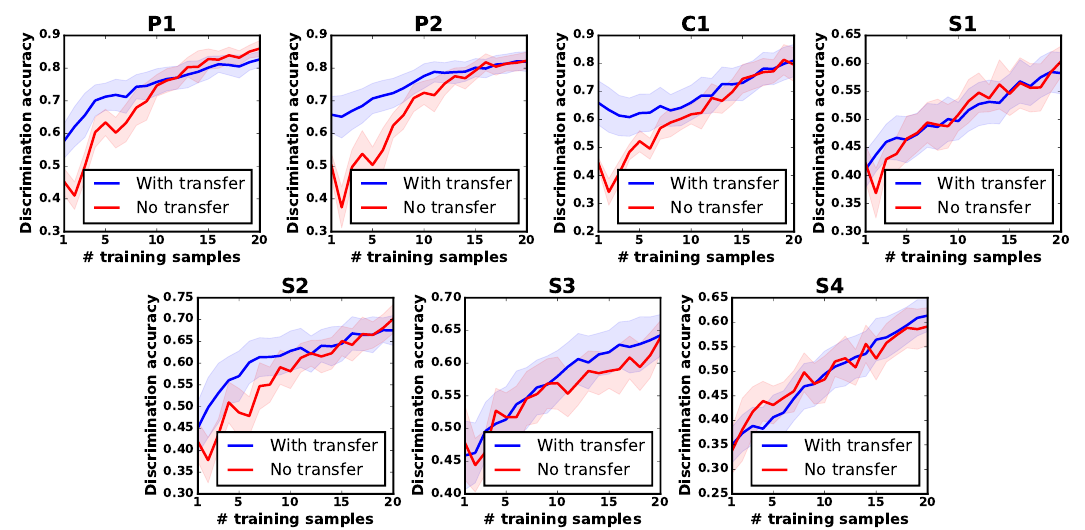
Figure 8. Transfer learning using only one exploratory action.